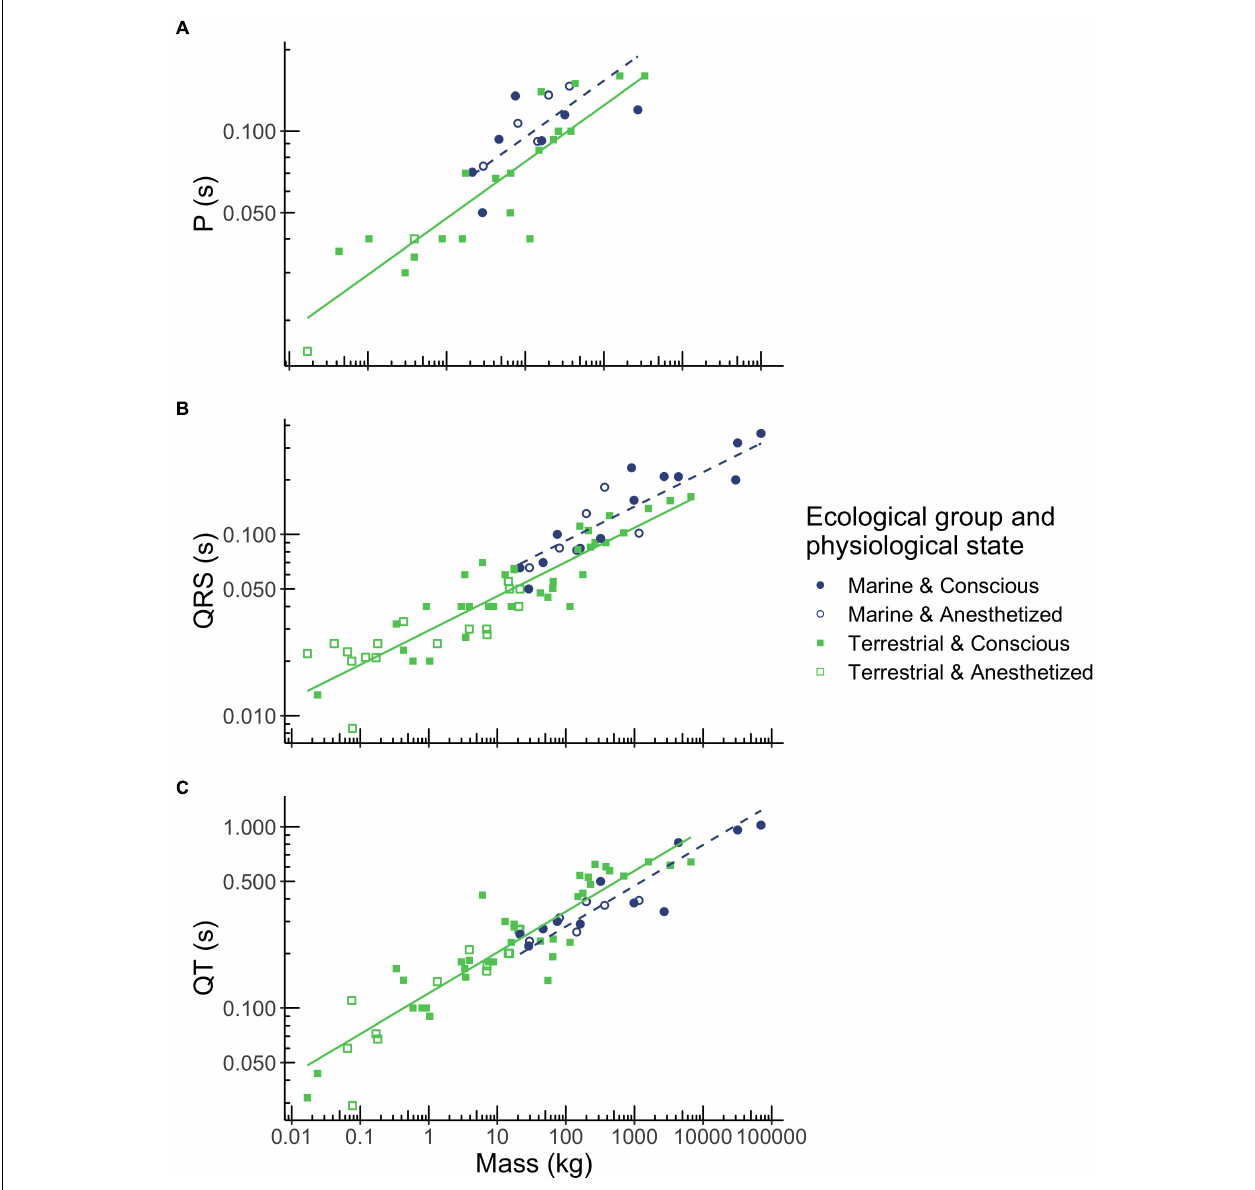
FIGURE 2 | Relationships between body mass, ecological group and P wave duration (A) , QRS complex duration (B) , and QT interval duration (C) in mammals. Mass was the best predictor for these three ECG parameters. However, durations also depended on ecological group (terrestrial mammals shown in green squares, marine mammals shown in blue circles), but not on physiological state (conscious mammals indicated by closed squares and circles, anesthetized mammals indicated by open squares and circles). Regression equations for each parameter are provided in Table 2